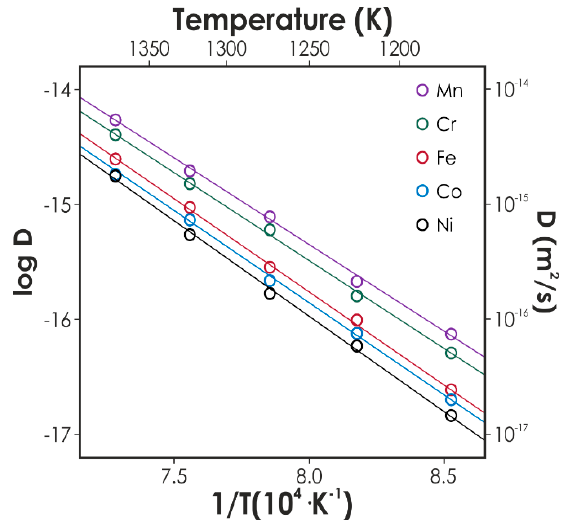
Figure 1. Temperature dependence of the tracer diffusion coefficients for all components in the Co-Cr-Fe-Mn-Ni system (after [28]). Reprinted from Acta Materialia 61 (2013), Sluggish diffusion in